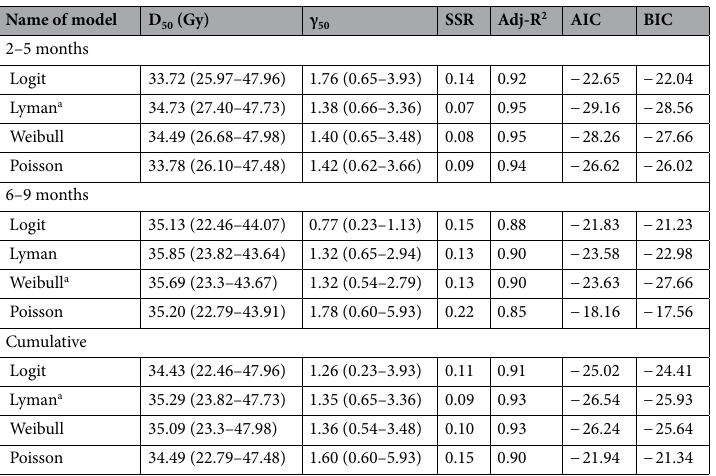
Table 1. D 50 and γ 50 values. Population average and range values (in parenthesis) for D 50 and γ 50 at any given time point were calculated for Logit, Lyman, Weibull, and Poisson models to the six data sets at each time frame. D 50 is the dose at which 50% of maximal CT HU change was expected to arise, and γ 50 is the normalized dose response gradient at the D 50 level. Also shown here are the computed sum of squared residuals (SSR), Adjusted R 2 (Adj-R 2 ), Akaike information criterion (AIC) and the Bayesian information criterion (BIC) for each model fit. a The best fit model based on the lowest SSR, AIC and BIC and the highest adj-R 2